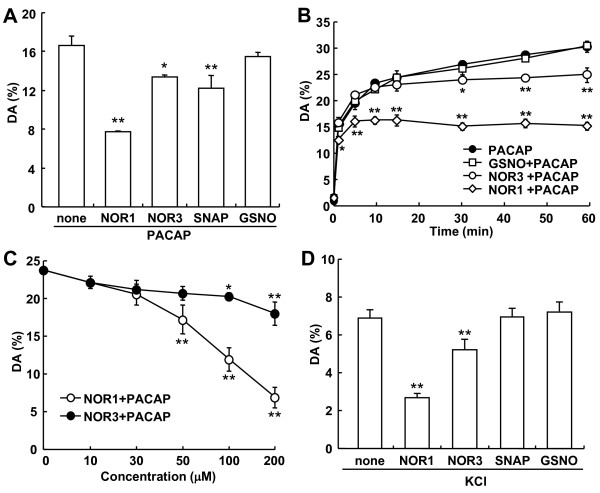
Effect of NO donors on PACAP-stimulated dopamine release from PC 12 cells. A. Inhibition of PACAP-stimulated dopamine release by NO donors. PC12 cells (4 × 105 cells/well) cultured on 24-well dishes were preincubated for 30 min with NOR1, NOR3, SNAP or GSNO (100 μM concentration of each) and then stimulated with 10 nM PACAP for 5 min in the presence of 10 μM imipramine, an inhibitor of catecholamine reuptake. Dopamine released into the medium and cellular dopamine were measured by HPLC as described in "Methods." *P < 0.05; **P < 0.01 vs. without NO donor. B. Time course of inhibition of PACAP-stimulated dopamine release by NO donors. PC12 cells were stimulated with 10 nM PACAP in the absence and presence of 100 μM NOR1, NOR3 or GSNO, and 10 μM imipramine for the indicated times. *P < 0.05; **P < 0.01 vs. PACAP alone. C. Concentration dependency of NOR1 and NOR3 for the inhibition of PACAP-stimulated dopamine release from PC12 cells. PC12 cells were stimulated for 10 min with 10 nM PACAP in the presence of various concentrations of NOR1 or NOR3 and 10 μM imipramine. Released dopamine (mean ± SD, n = 3) was expressed as a percentage of total dopamine (7.2 ± 0.8 ng/well) in PC12 cells. *P < 0.05; **P < 0.01 vs. without NO donor. D. Inhibition by NO donors of the KCl-stimulated dopamine release in PC12 cells. PC12 cells (4 × 105 cells/well) cultured on 24-well dishes were preincubated for 30 min with NOR1, NOR3, SNAP or GSNO (100 μM concentration of each) in the presence of 10 μM imipramine and then stimulated with 45 mM KCl for 5 min. Dopamine released into the medium (mean ± SD, n = 3) was measured as described above and expressed as a percentage of total dopamine in PC12 cells. **P < 0.01 vs. without NO donor.